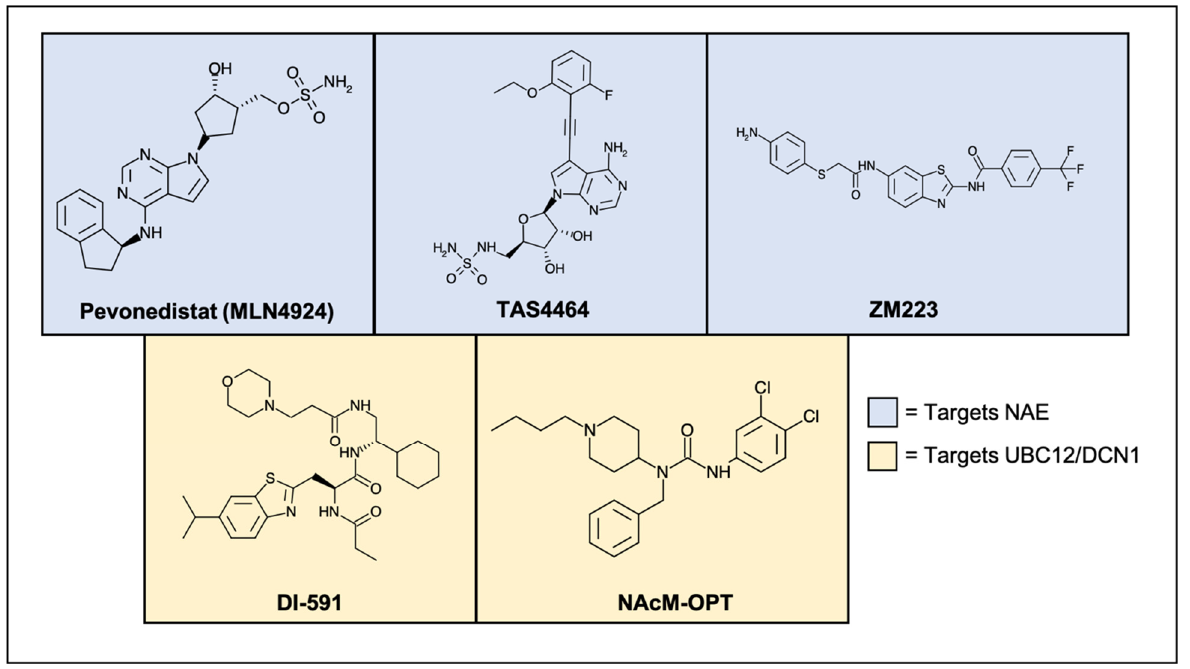
Figure 2. Chemical structures of molecules that inhibit various proteins in the NEDDylation pathway. PEV and TAS4464 are sulfonamide-based NAE inhibitors which have entered clinical trials. PEV has displayed promising clinical activity in a variety of cancer types. ZM223 does not contain a sulfonamide group and inhibits NAE through different covalent interactions. DI-591 and NAcM-OPT competitively bind and inhibit the interaction of UBC12 and DCN1, thus prohibiting downstream NEDD8 conjugation.